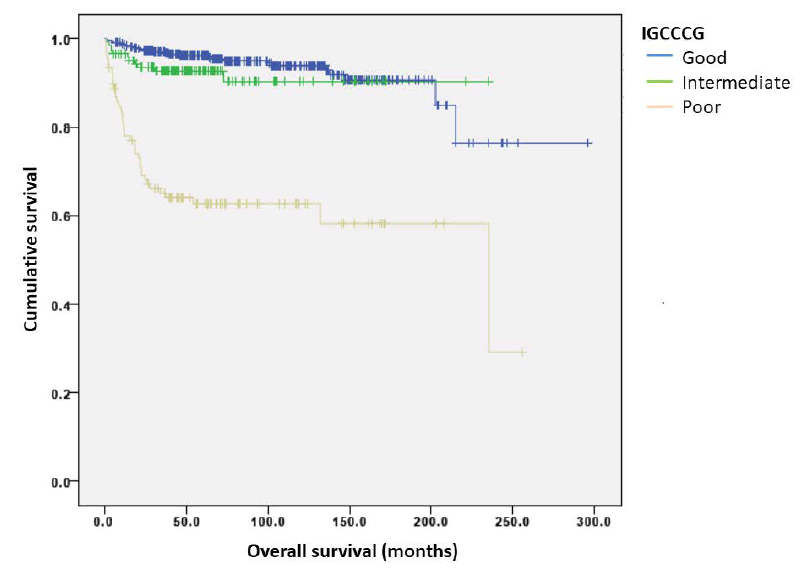
Figure 1. Kaplan–Meier curves of overall survival (OS) according to the IGCCCG